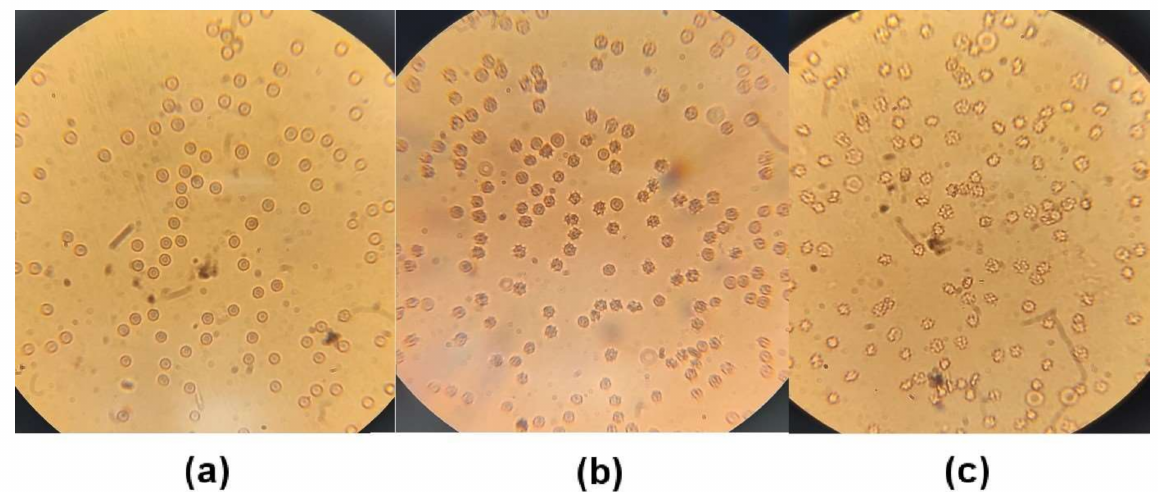
Figure 7. Representative photographs of erythrocyte morphology. Control group ( a ), MLN-4760-treated group (ACE2 inhibition) ( b ), MNL-4760 and zofenopril-treated group ( c